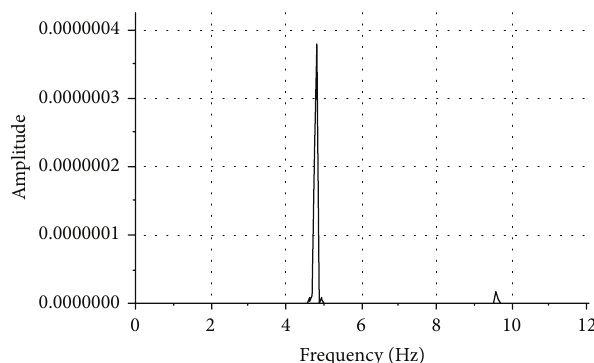
Figure 10: Power density spectrum of the acceleration response of the shaking table for sine excitation.